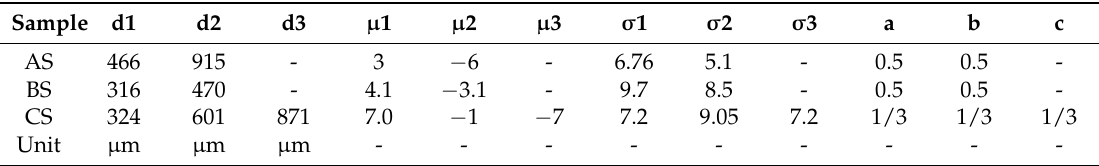
Table 1. Parameters of simulated polydisperse PSD data